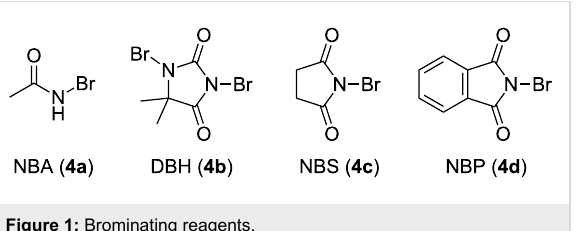
Figure 1: Brominating reagents.